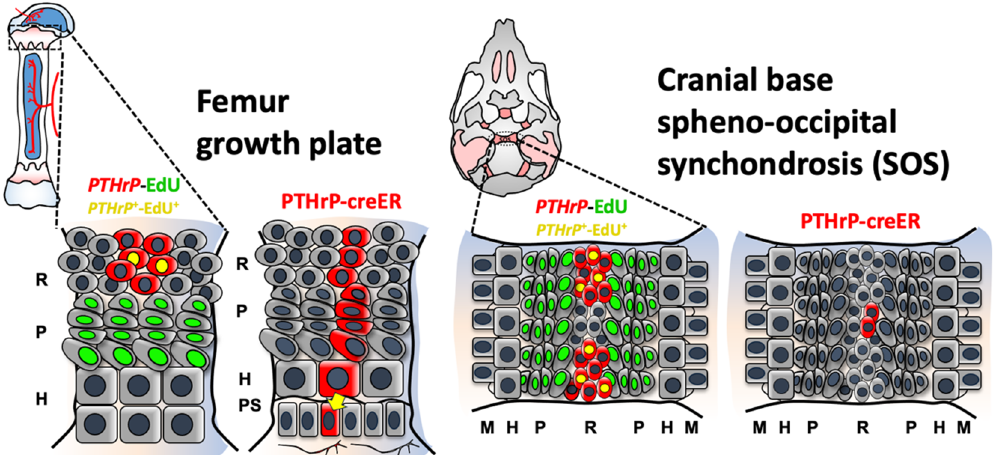
Figure 4. Cranial base synchondrosis lacks PTHrP + column-forming chondrocytes in the resting zone. PTHrP + chondrocytes are present both in the femoral growth plate and cranial base synchon- drosis, which are generally characterized by their slow-cycling nature. Our cell-lineage analysis using Pthrp-creER; R26R tdTomato mice reveals that PTHrP + chondrocytes in the synchondrosis fail to form columnar chondrocytes. Thus, PTHrP + chondrocytes do not possess the characteristics of skeletal stem cells in the synchondrosis, highlighting functional differences between skeletal stem cells and their niches in two classes of endochondral bones—the cranial base and long bone. Red cells: mCherry + , tdTomato + , Green cells: EdU + , Yellow cells: mCherry + ; EdU + . R: resting zone, P: proliferating zone, H: hypertrophic zone, PS: primary spongiosa, M: metaphyseal